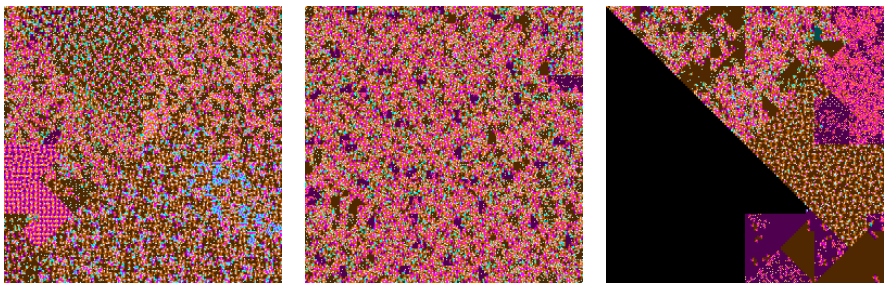
Figure 2. A 2D representation of a clean .rtf file (175